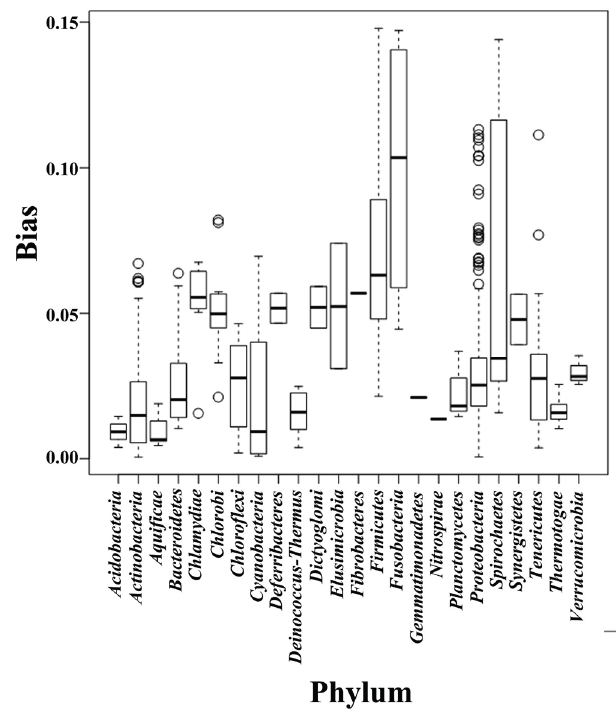
Figure 1. Box-and-whiskers represent for composition bias of all genomes, which sorted into 24 phyla. The bottom and top of box mark the first and third quartiles, and the band inside the box denotes the median. The ends of the whiskers in each plot represent the lowest datum still within 1.5 IQR (interquartile range) of the lower quartiles, and the highest datum still within 1.5 IQR of the upper quartiles. Any data not included between the whiskers is plotted as an outlier with a small circle. This boxplot graphically depict the different bias distribution in respective phylum.